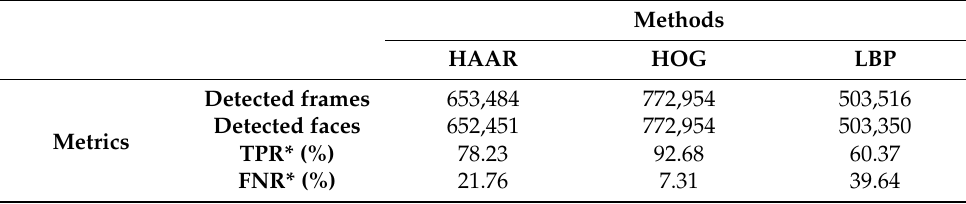
Table 3. Comparison of different face recognition algorithms (Adouani et al.,